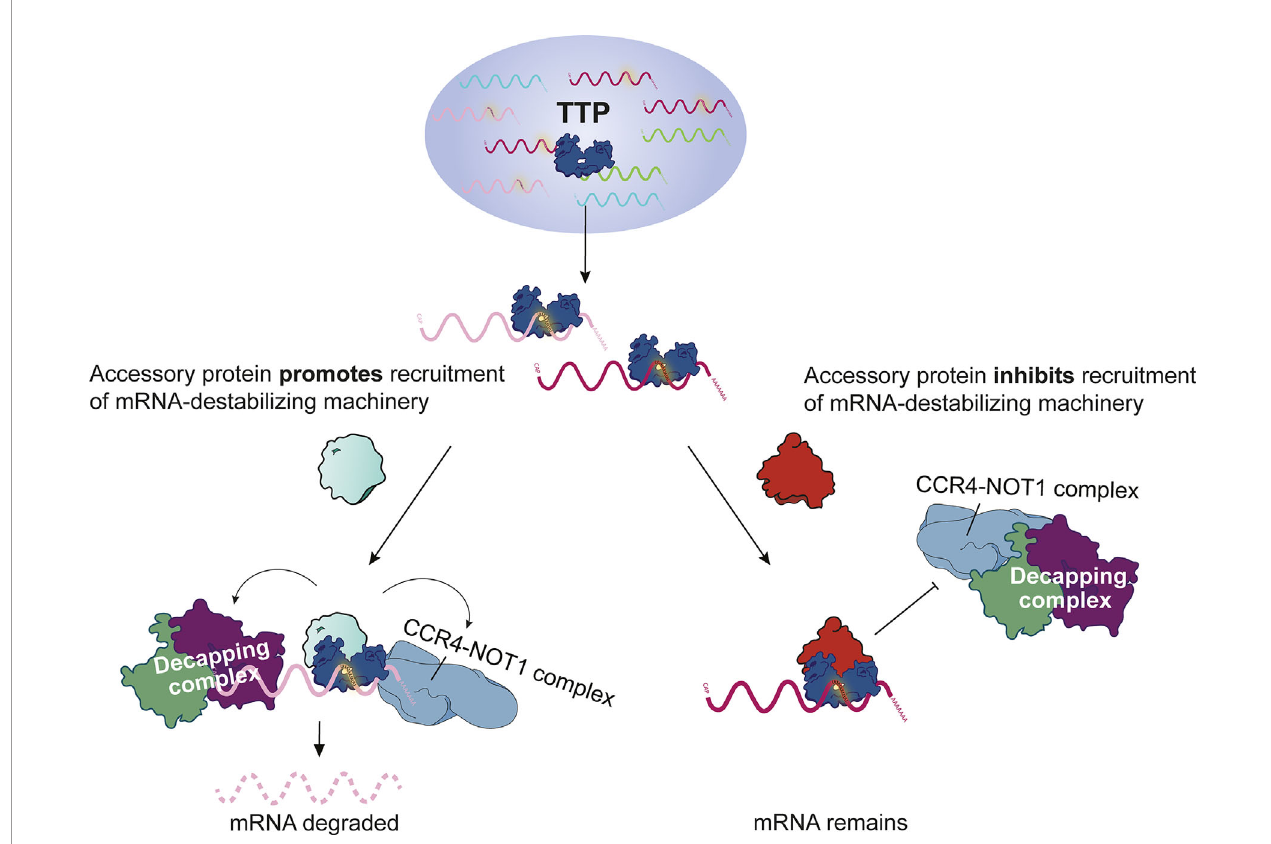
FIGURE 2 | Model of functional and silent binding of TTP to mRNA. Model of possible mechanisms explaining how mRNA-bound TTP destabilizes some mRNAs but not